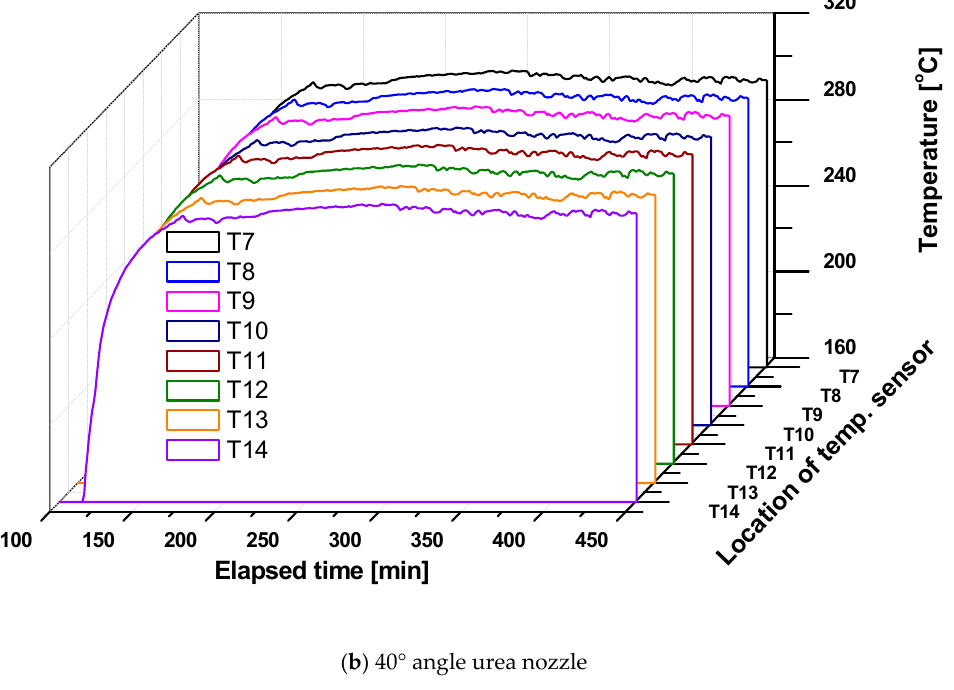
Figure 7. Temperature distributions in accordance with the variations of a 30° and 40° urea nozzle.